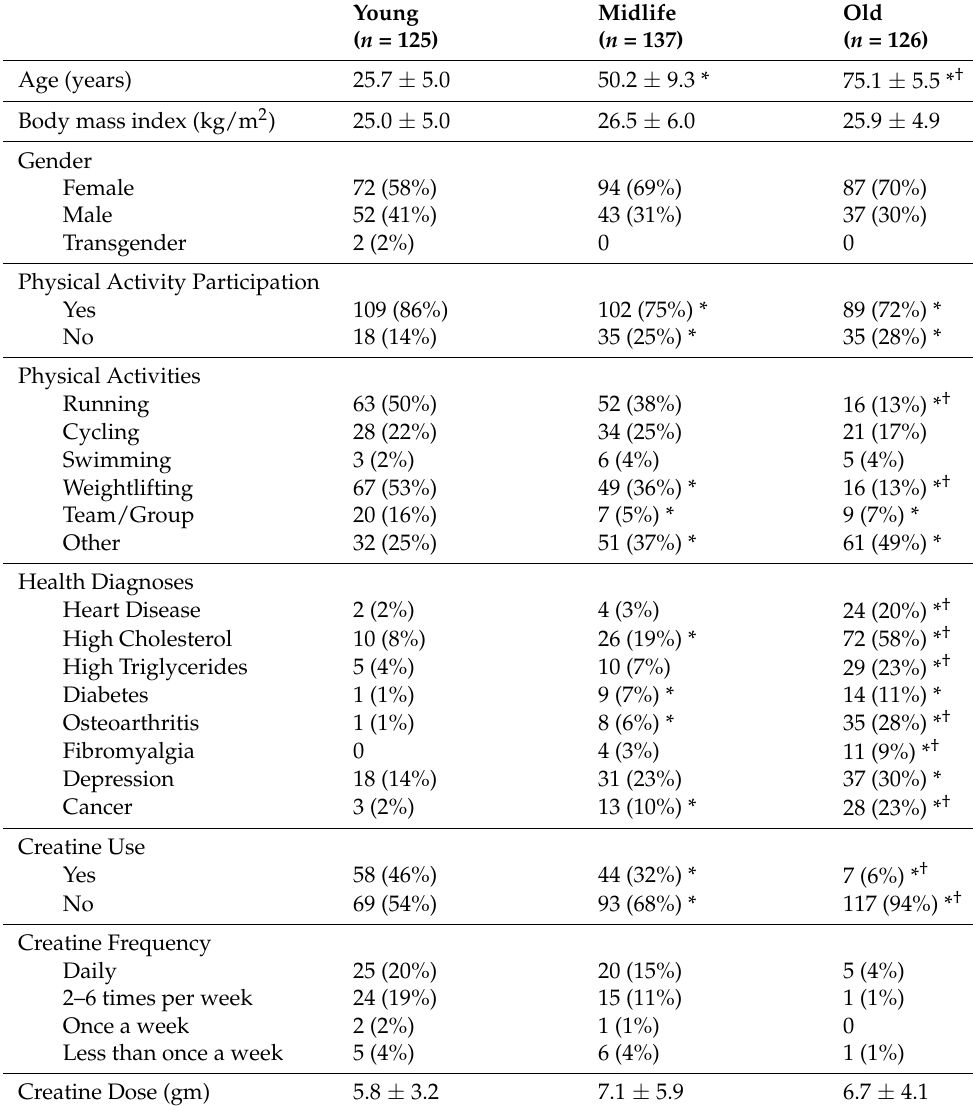
Table 3. Between-group comparison of respondents based on